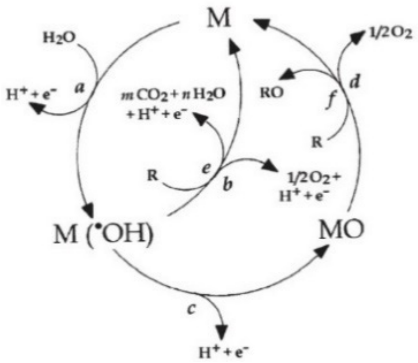
Figure 9. Schematic mechanism of anodic oxidation of organic compounds with simultaneous oxygen evolution at the inactive anode (reactions a, b, and e) and at the active anode (reactions a, c, d, and f). Reproduced from Ref. [60]. Copyright 2006 Royal Society of Chemistry.